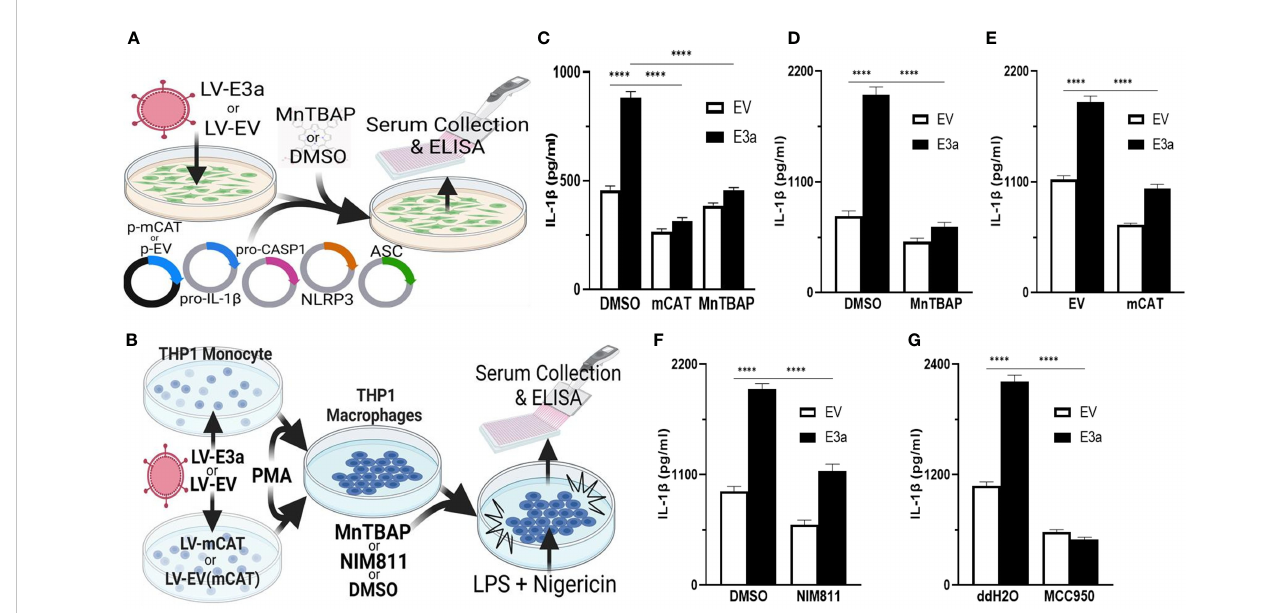
FIGURE 3 mROS and the mtPTP are required for activation of the NLRP3-I by the 2-E+2-3a viroporins. (A, B) Experimental design used to assess NLRP3-activated by IL-1 b in cell-free supernatants quanti fi ed by ELISA. (A) 293T cells with an NLRP3-I reconstitution system (NLRP3, ASC, pro-CASP1, pro-IL-1 b ) and (B) THP1 differentiated into macrophages and primed with LPS + nigericin. (C) 293T cells transfected with LV-EV or LV-E3a were transfected with the NLRP3-I plasmids and p-mCAT or its control plasmid p-EV, or cultured in the presence or absence of 50 m M MnTBAP. (D, F, G) THP1 cells were transduced with LV-EV or LV-E3a, differentiated into macrophages, treated with LPS + nigericin, and treated with 5 m M MCC950, 100 m M MnTBAP or 10 m M NIM811, the supernatants analyzed for IL-1 b by ELISA. (E) THP1 cells stably expressing LV-mCAT or control plasmid were infected with LV-EV or LV- E3a, differentiated into macrophages, and supernatant IL-1 b levels determined via ELISA. Error bars represent SEM from 3 independent experiments; statistically signi fi cant data is indicated with asterisks